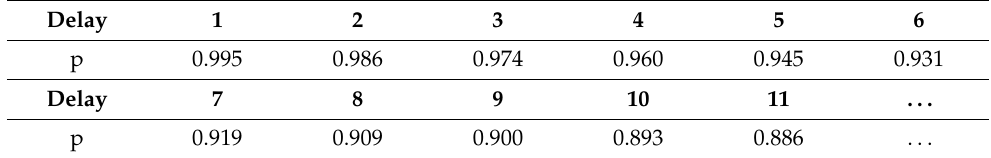
Table 4. Autocorrelation coefficient of power sequences.